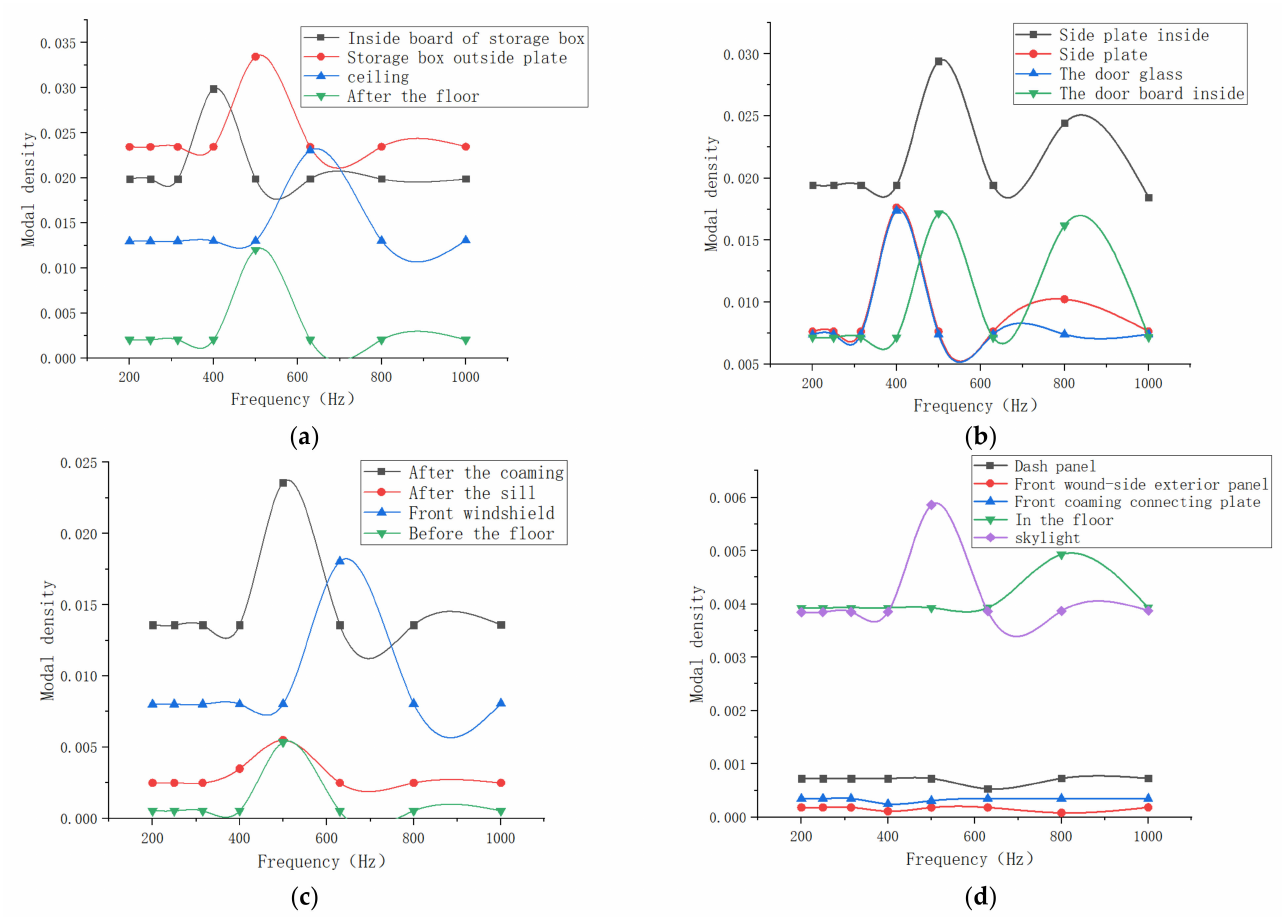
Figure 6. Modal density test results. ( a ) Test results of storage bins and ceilings; ( b ) Test results of side coiling and door panels; ( c ) Test results of the front windshield and front floor; ( d ) Test results of the instrument panel and